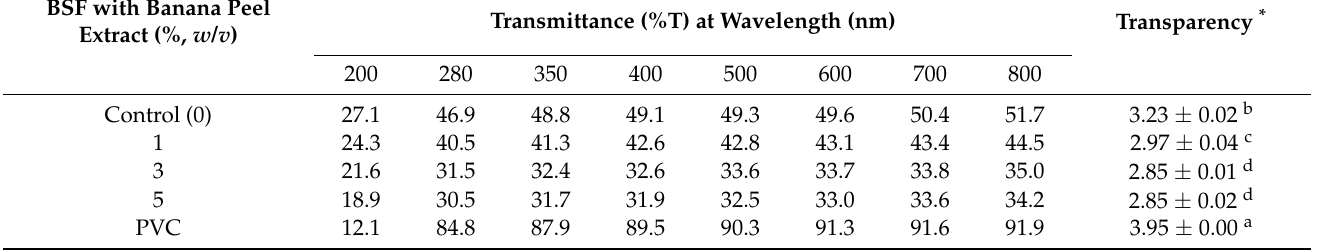
Table 3. Light transmission and transparency of banana starch films incorporated with banana peel extract at different concentrations in comparison with PVC